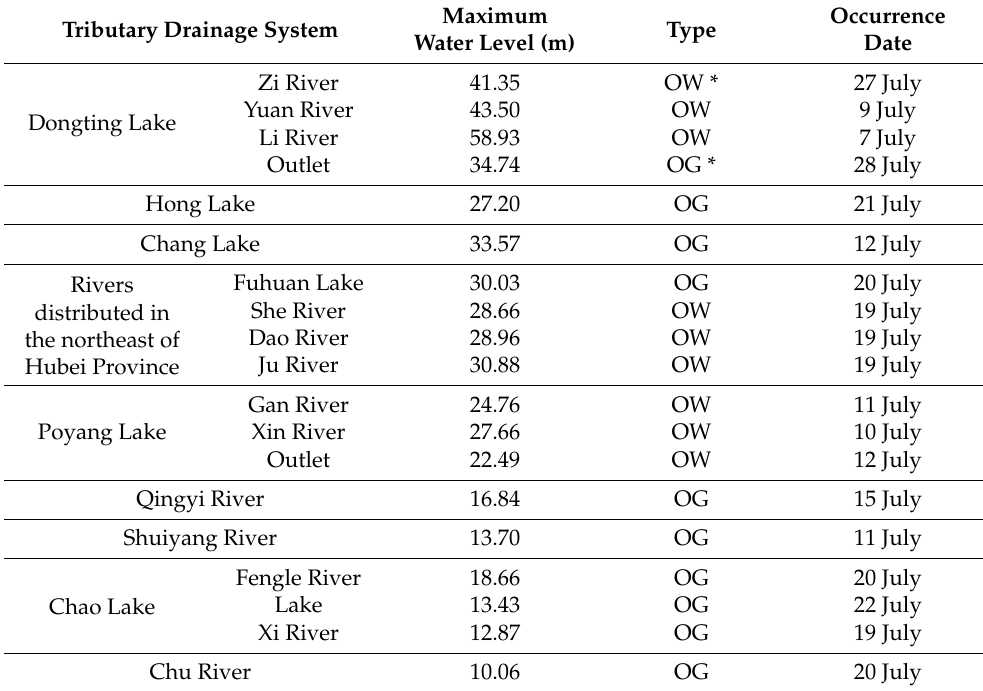
Table 3. Statistics of the over-warning and over-safety guarantee water level in 2020. Tributary Drainage System